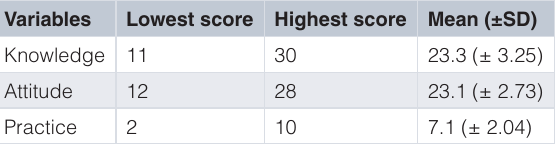
Table 2. Overall scores of participant’s knowledge, attitude and